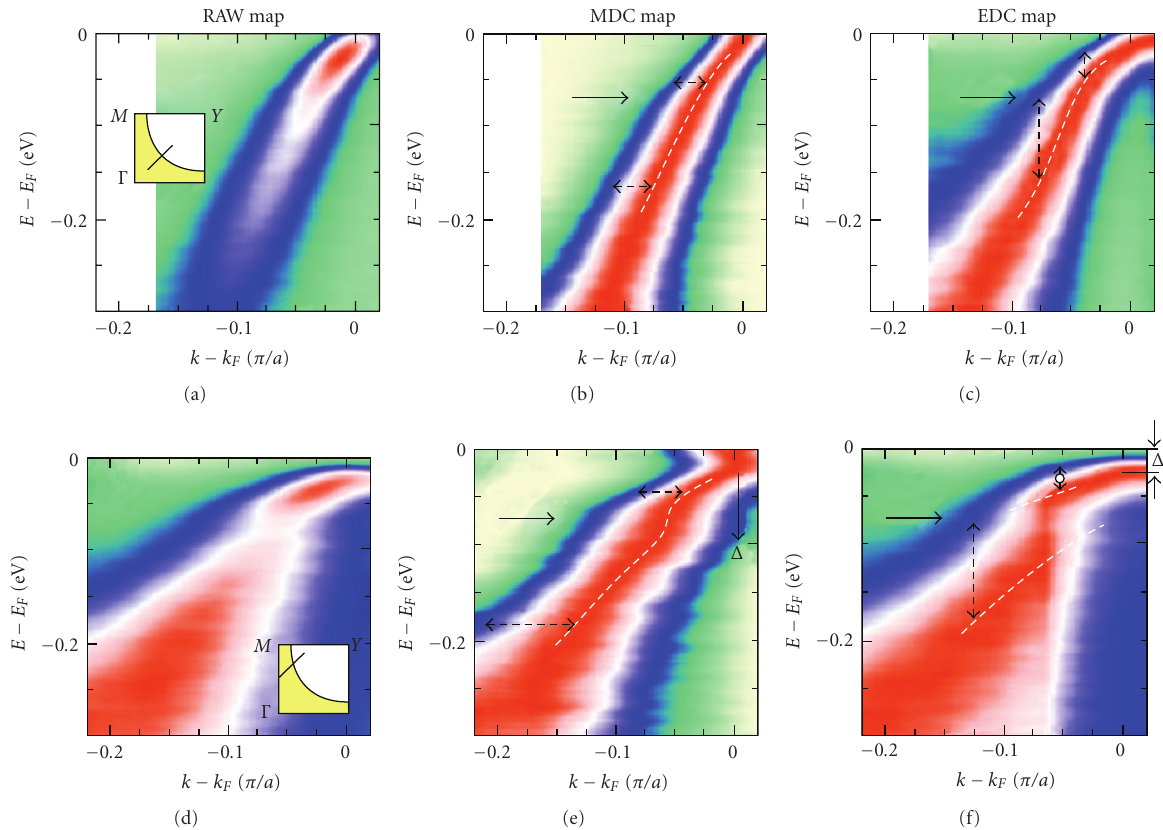
Figure 1: (a–c) ARPES data taken at 25 K on optimally doped Bi2212 superconductor ( T c = 92K), for a cut along the Γ Y direction through the nodal point in momentum space (indicated in panel (a) inset). (d–f) The same sample and orientation, but taken nearer the Brillouin zone (BZ) edge (or antinodal point) in momentum space (indicated in panel (d) inset). (a) and (d) Raw ARPES data taken with a color scale where intensity increases from pale yellow to green to blue to white to red. Here, blue (white) corresponds to 1 / 2 (3 / 4) of the maximum intensity. (b) and (e) Same data but as an “MDC map”, where each MDC has been normalized so that its maximum and minimum intensities are 1 and 0, respectively. (c) and (f) Same data but now each EDC has been appropriately normalized to create an “EDC map”. Thick black arrows indicate the energy of the bosonic mode while the Δ is the superconducting gap. Energy resolution used here is ∼ 15 meV.